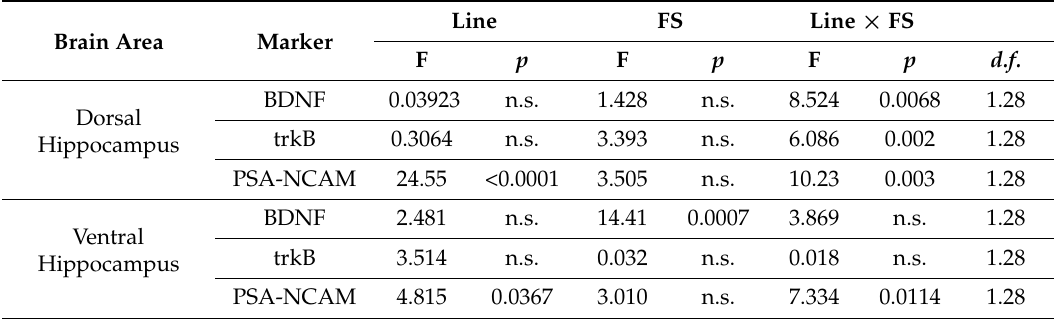
Table 1. F values and significance levels of two-way ANOVAs performed on western blot data, shown in Figures 2 and 3.